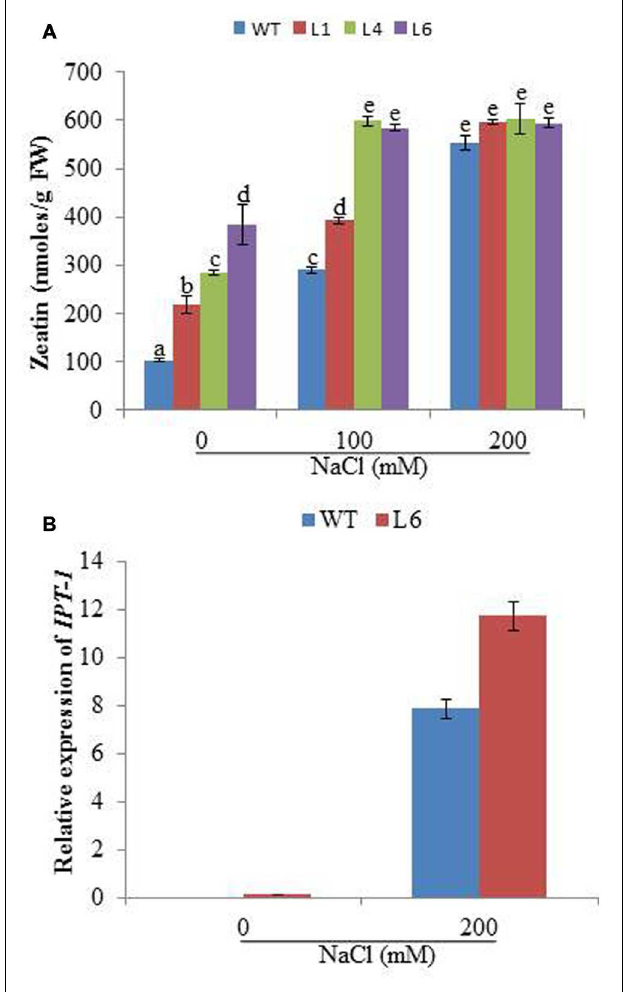
FIGURE 7 | (A) The zeatin concentration in WT and JcPR-10a transgenic lines (L1, L4, and L6) at different NaCl concentrations. Data represent the mean ± SE of three biological repeats. (B) Relative-fold expression of IPT-1 gene in WT and L6 transgenic line at 0 and 200 mM NaCl concentrations. Data represent the mean ± SE of three biological repeats.